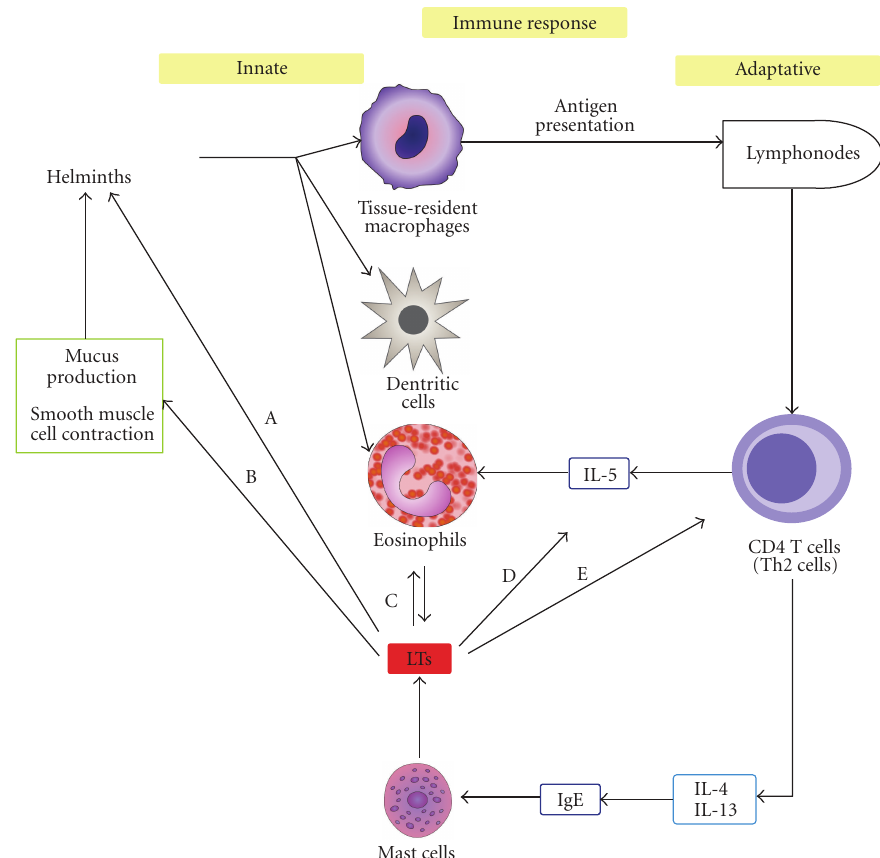
Figure 3: Modulation of innate and adaptive immune responses during the helminth infections. Initial exposure of the immune system to parasitic antigens leads to the activation of a subset of T cells known as Th2 cells, which orchestrate the immune response to these exogenous antigens by secreting cytokines, including IL-4, IL-5 and IL-13. The accumulation of eosinophils in the blood and in di ff erent organs and tissues as well as the degranulation of IgE-sensitized mast cells is hallmarks of helminthiasis. Eosinophils and mast cells are sources of LTs. (A) CysLTs are required for molting of the infectious larvae (e.g., Brugia malayi larvae). (B) CysLTs, alone or in conjunction with Th2 cytokines, cause contractility of smooth muscle cells, the permeability of epithelial cells, and the production of mucus, thereby contributing to worm expulsion. (C) LTB 4 recruits and activates inflammatory cells such as eosinophils to favor the kill of helminths. (D) LTB 4 regulates IL-5 production by human T lymphocytes and consequently contributes to parasite elimination. (E) LTB 4 induces chemotaxis of CD4 + T